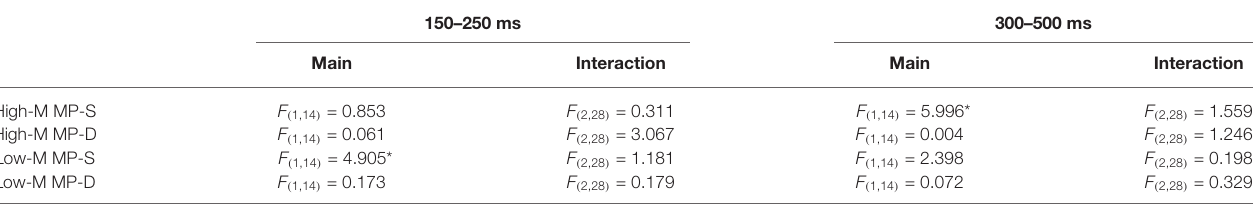
TABLE 3 | The results of repeated measures ANOVA for false recognition .